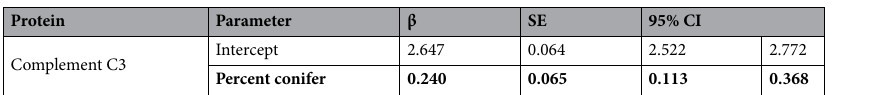
Table 5. Estimate (β), standard error (SE) and 95% confidence interval (CI) of the explanation variables in models with ΔAICc < 2 for the expression of complement C3 in skin samples collected from grizzly bears across Alberta, Canada. Variables with 95% CI that do not cross zero are shown in bold